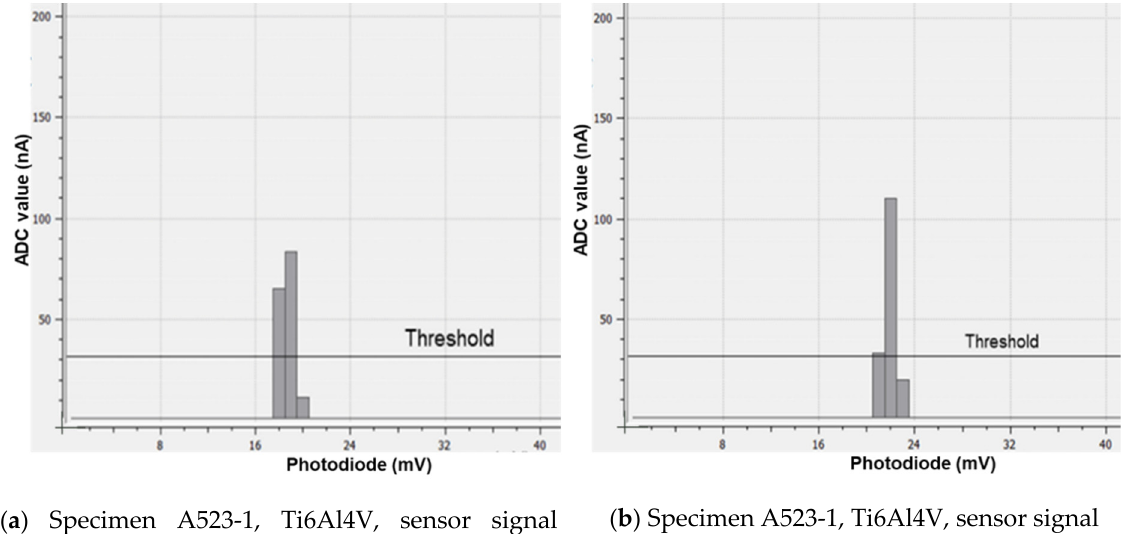
( b ) Specimen A523-1, Ti6Al4V, sensor signal strength at ~400 °C temperature. Figure 9. Specimen A523-1, Ti6Al4V, comparison of sensor signal strength at room and 400 °C temperatures.